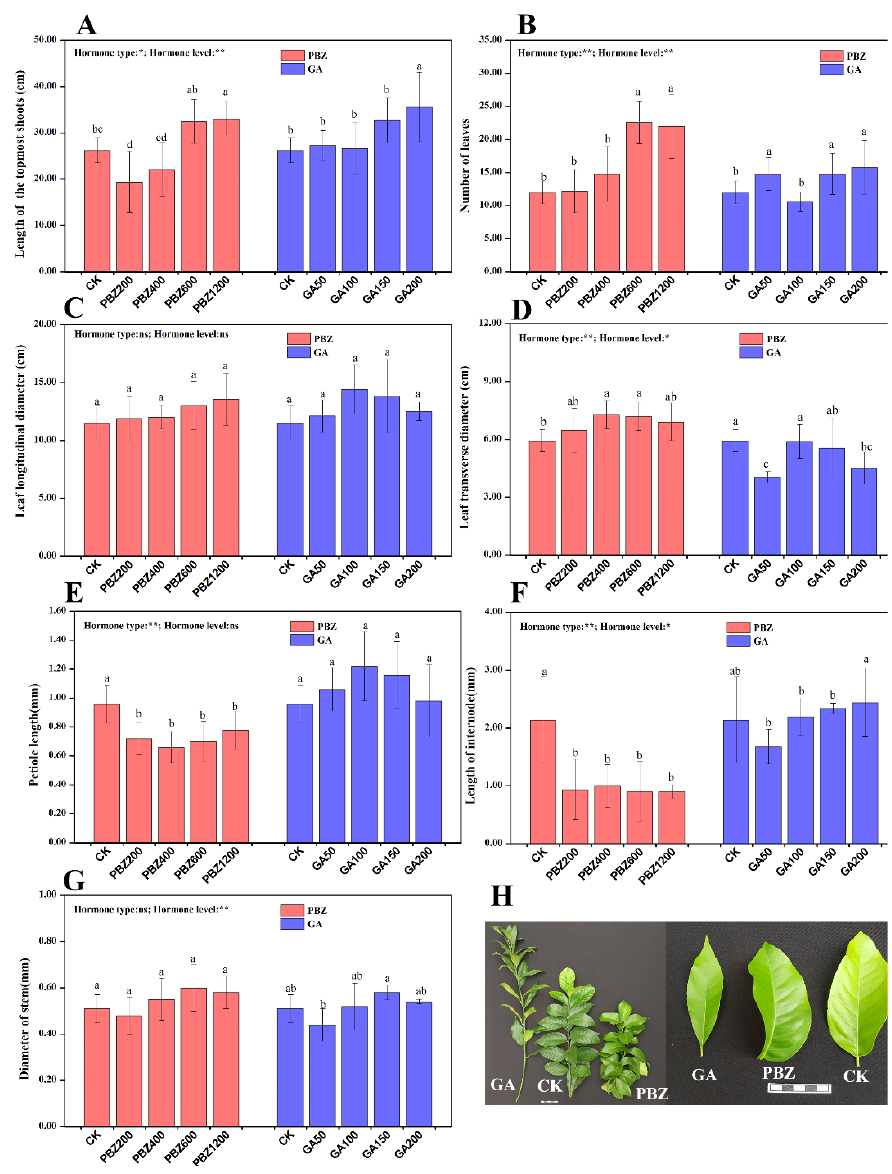
Figure 1. Effects of hormone regulation on the length of the topmost shoots ( A ), number of leaves ( B ), leaf longitudinal diameter ( C ), leaf transverse diameter ( D ), petiole length ( E ), length of internode ( F ), diameter of stem ( G ). ( H ) Plant and leaf morphology after treatment with different hormones. The red and blue bars represent PBZ and GA, respectively. Different letters (a, b, c and d) denote significant differences based on a p value < 0.05. * denotes significant difference ( p < 0.05), and ** denotes extremely significant difference ( p < 0.01).